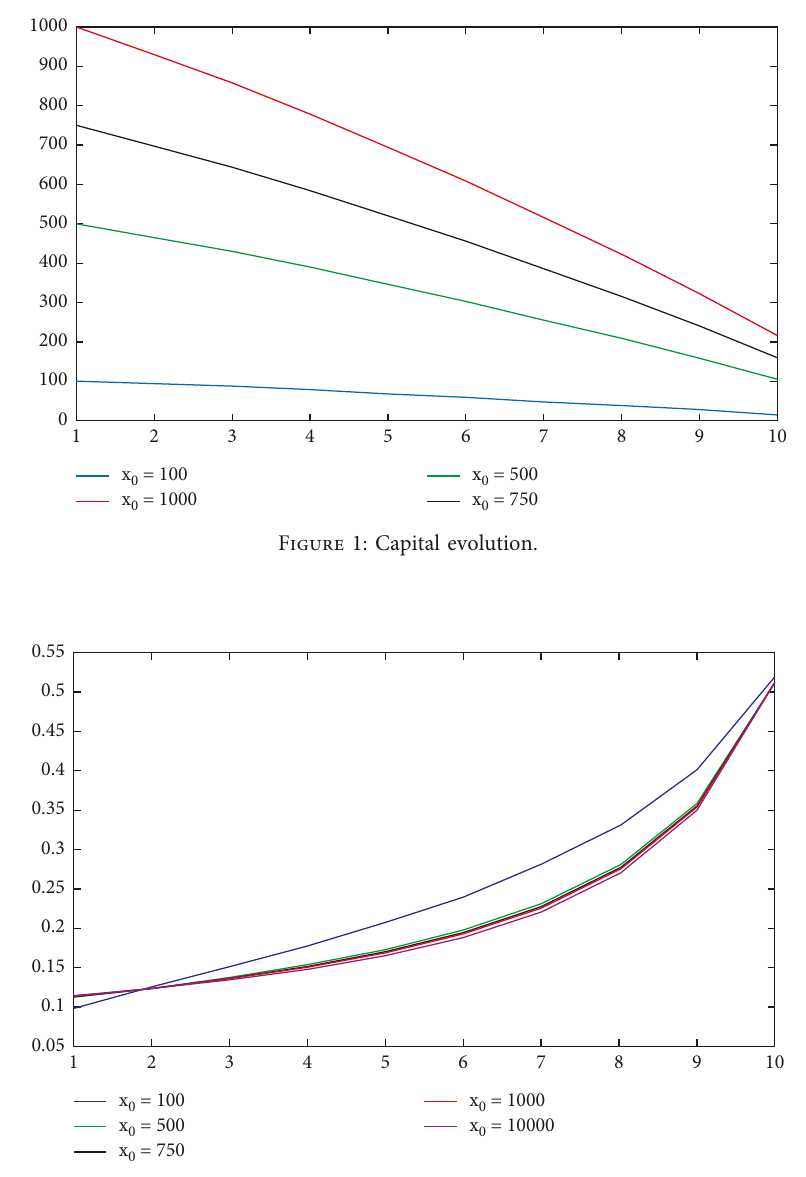
Figure 2: Relative consumption